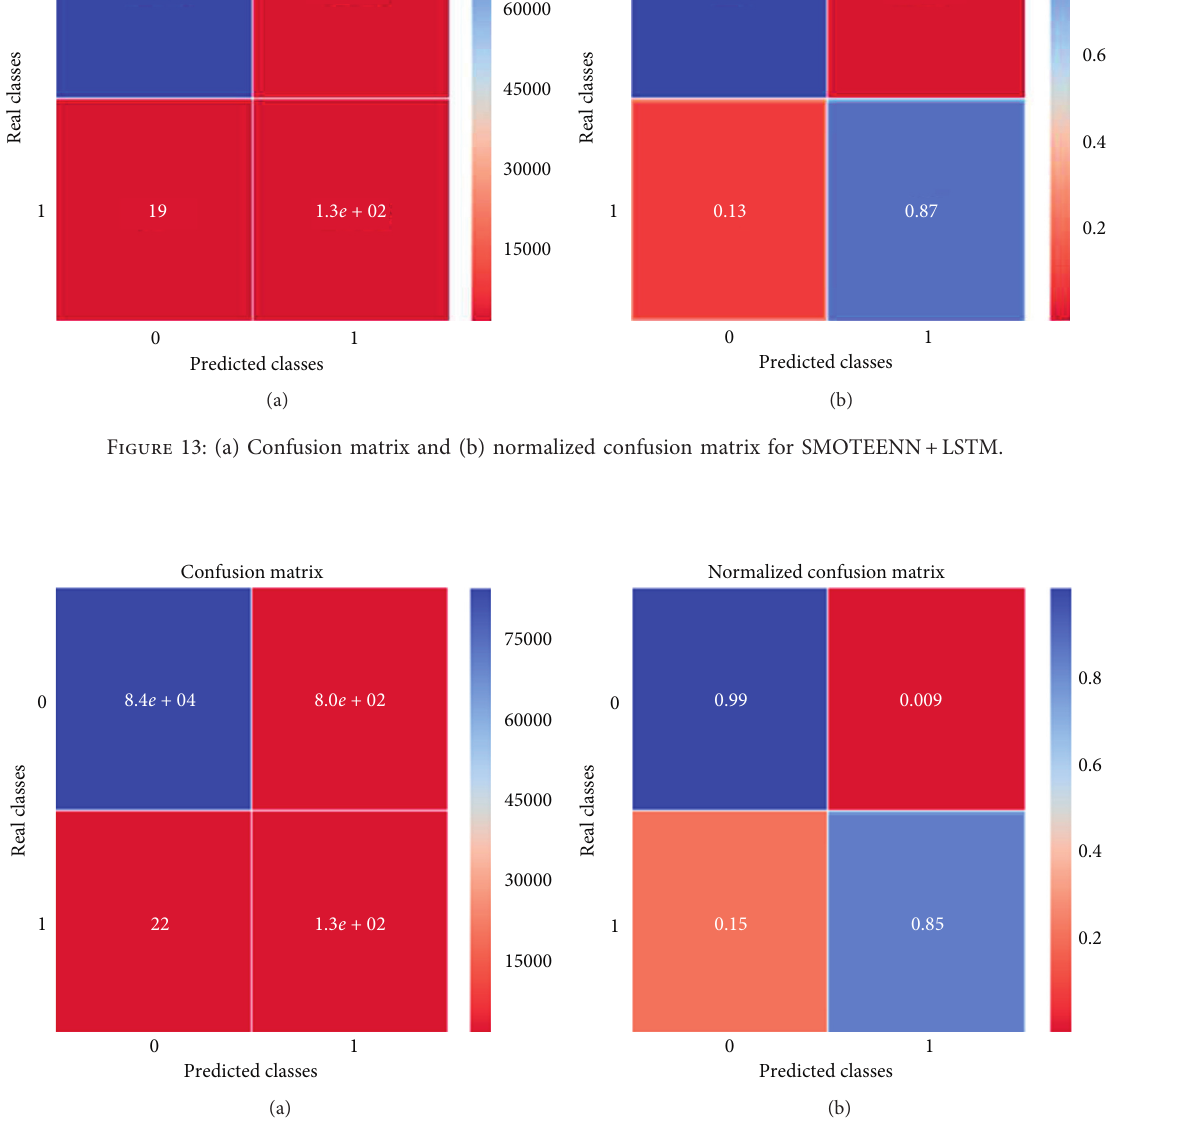
Figure 14: (a) Confusion matrix and (b) normalized confusion matrix for